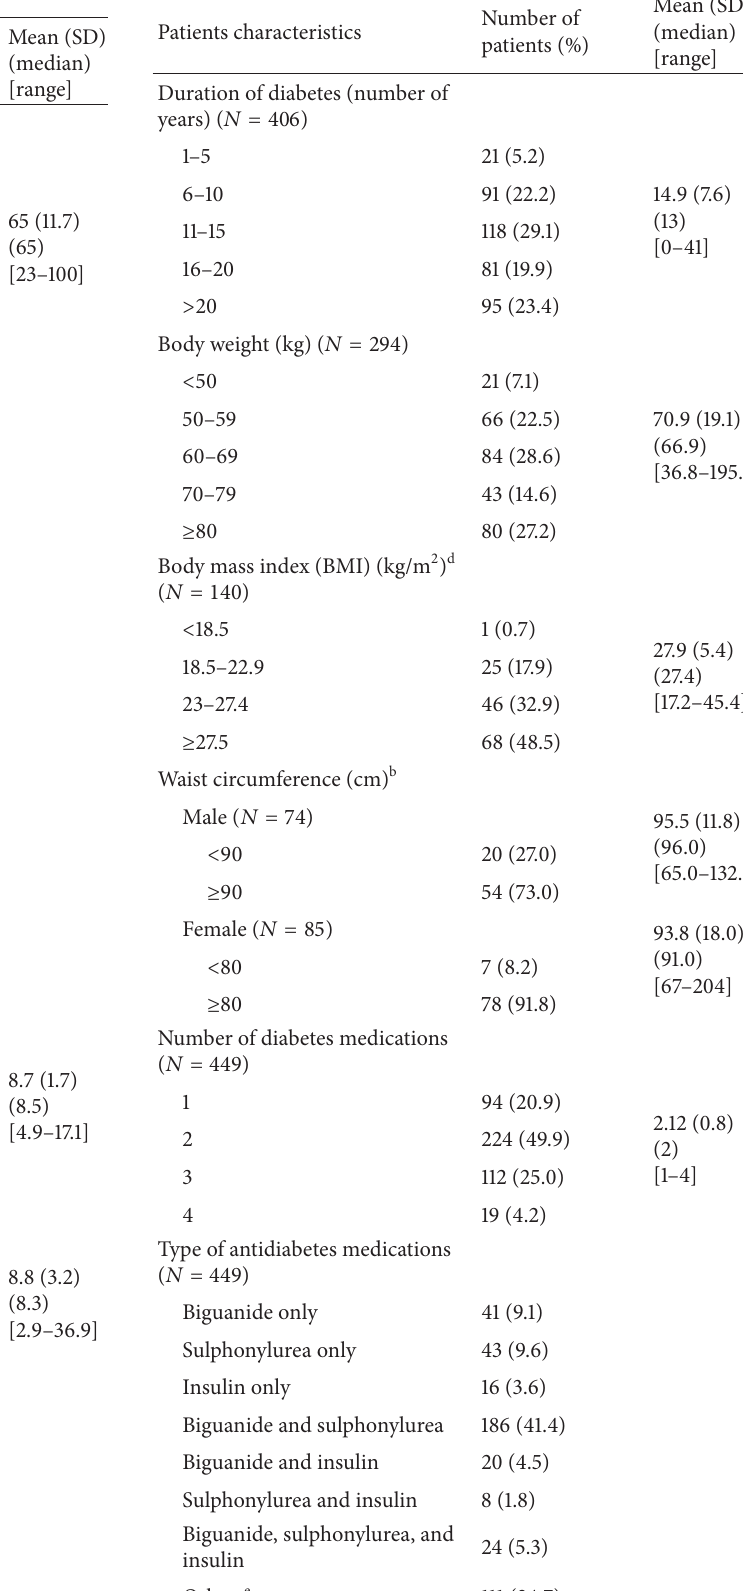
Table 1: Baseline demographic and clinical characteristics of